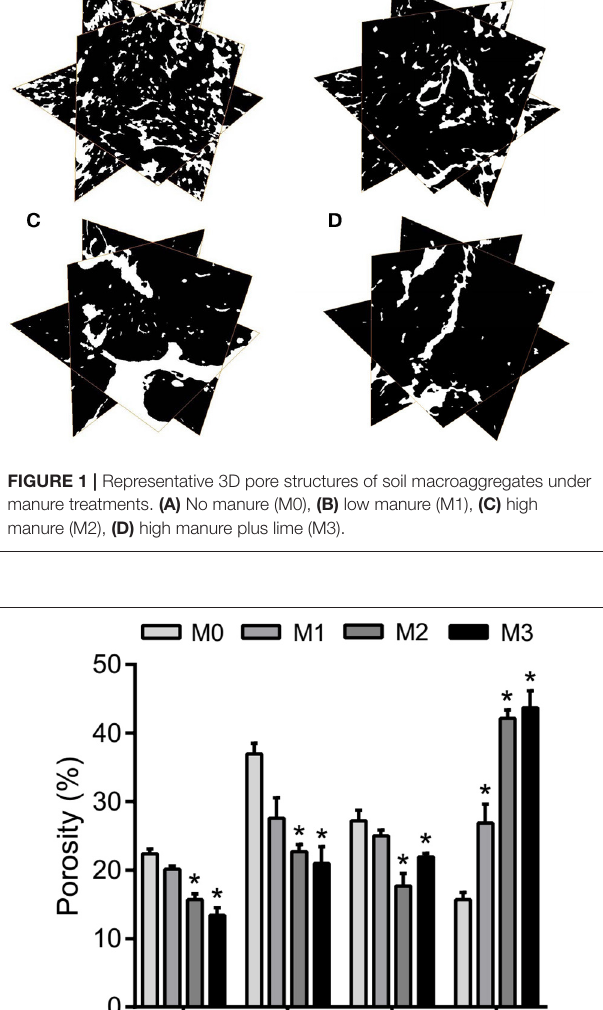
from that under the M0 and M1 treatments ( Figure 4 , P < 0.001). The ratio of B/F increased significantly, but the ratio ( Supplementary Figure 1 , P < 0.05). The ratios of cyclopropyl fatty acids to their precursors (17:0 cyclopropyl per precursor and 19:0 cyclopropyl per precursor) calculated as two stress indexes were in the microbial communities. The ratios of 17:0